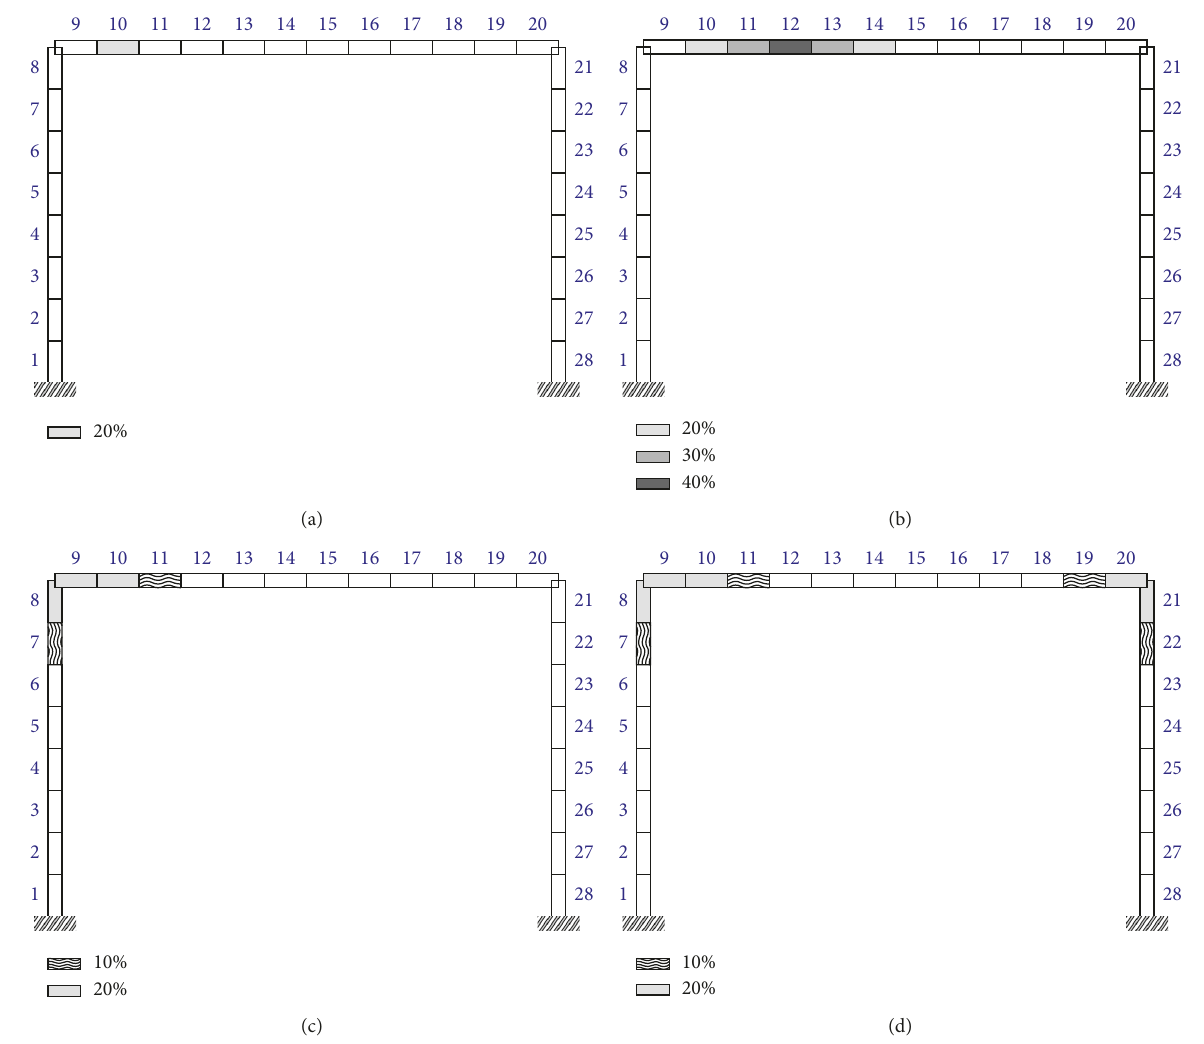
Figure 11: Frame example: the four different damage scenarios. (a) Scenario 1, (b) scenario 2, (c) scenario 3, and (d) scenario